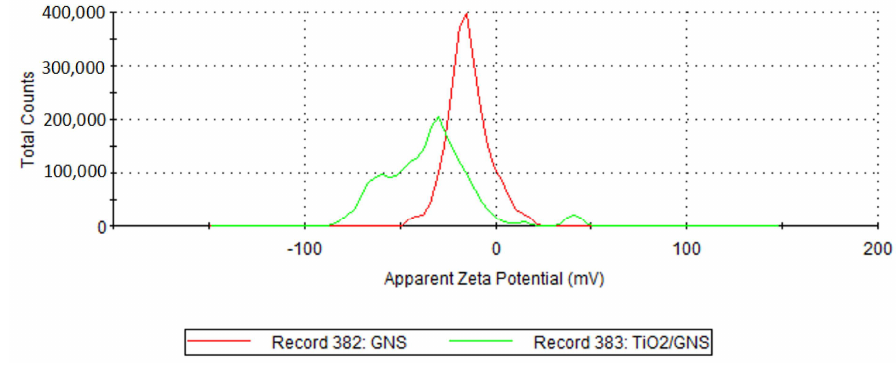
Figure 6. Zeta potential of GNs and TiO 2 /GNs.